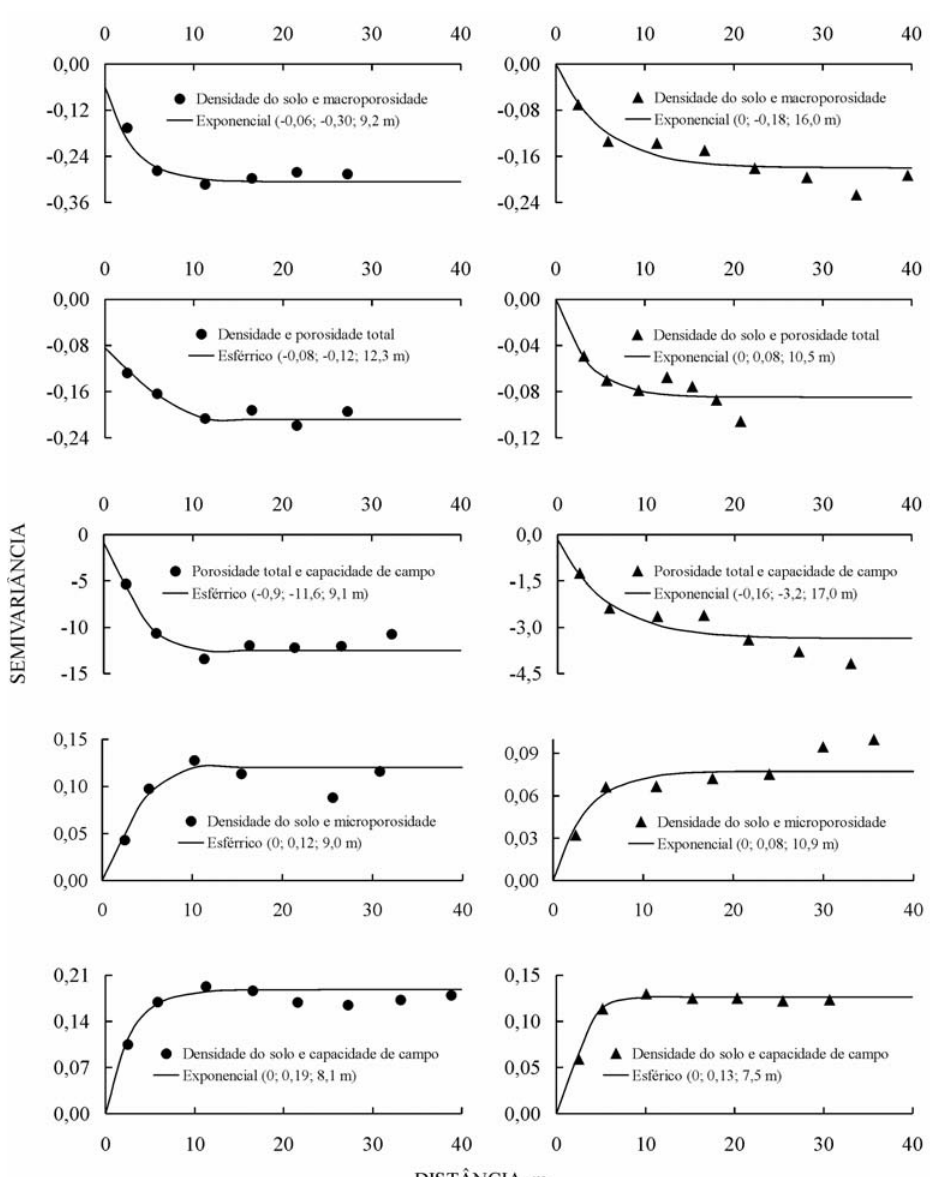
Figura 2. Semivariogramas cruzados e modelos matemáticos ajustados (esférico e exponencial) à densidade do solo, à macroporosidade, à microporosidade, à porosidade total e à capacidade de campo no plantio direto ( ) e no preparo convencional ( ). Os valores dentro dos parênteses correspondem, respectivamente, aos efeitos pepita, patamar e